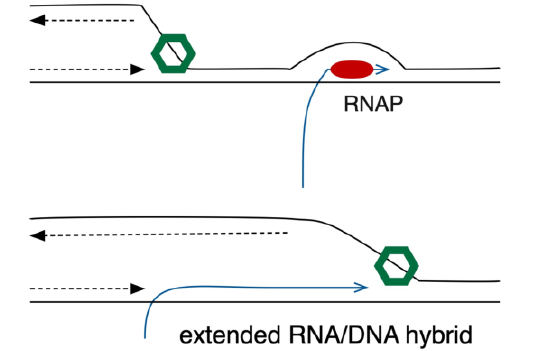
FIGURE 2. (A) Head-on collisions between the replication fork and transcription complexes. Because the DnaB fork helicase (green) translocates on the lagging strand template, head-on collisions with RNAP (red) blocks fork progression. (B) Codirectional colli- sions. DnaB fork helicase can proceed unimpeded, but fork un- winding can stabilize extensive R-loops (RNA/DNA hybrids) behind RNAP. Copyright © American Society for Microbiology,